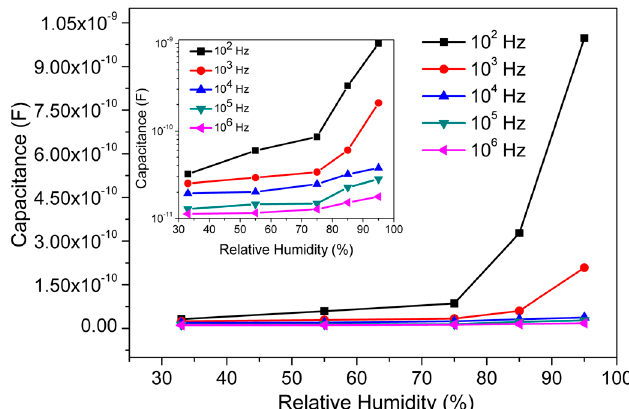
Figure 5. The response curves of the capacitance versus relative humidity (RH) at different frequencies of CMFTO electro-ceramic at 25 ° C. Inset image represents the variation of capacitance with RH at 25 °C at different frequency in logarithmic scale (log( C ) vs. % RH). Note: the capacitance increases monotonically with % RH at different frequencies, but increased rate is faster at 10 2 Hz .